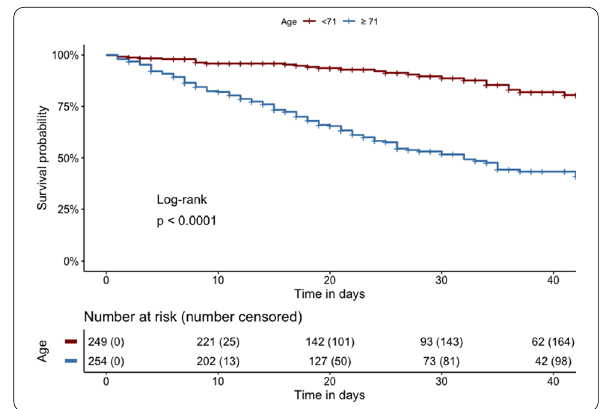
Figure 1: Age and hospital